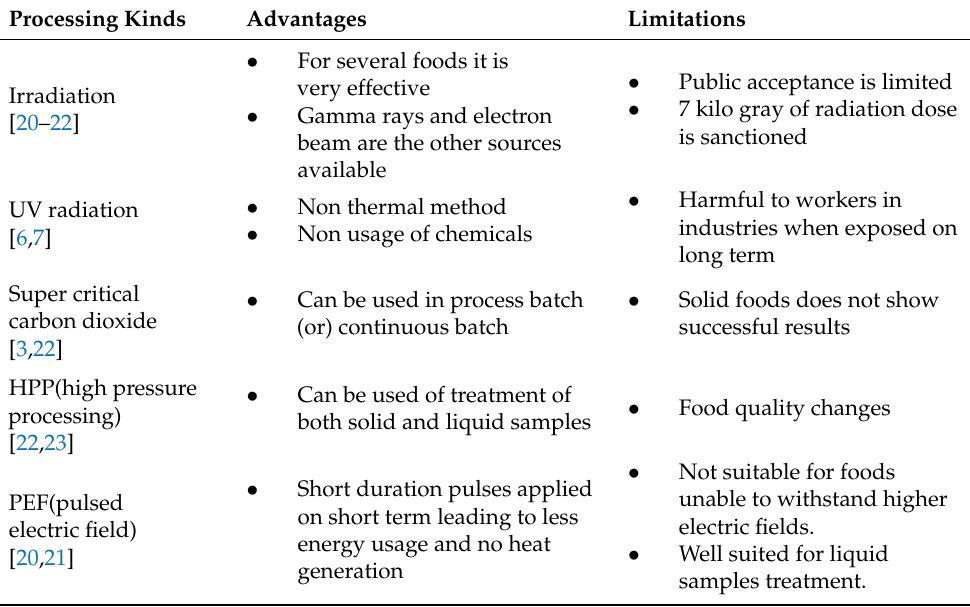
Table 1. Non thermal processing methods — limitations and advantages.